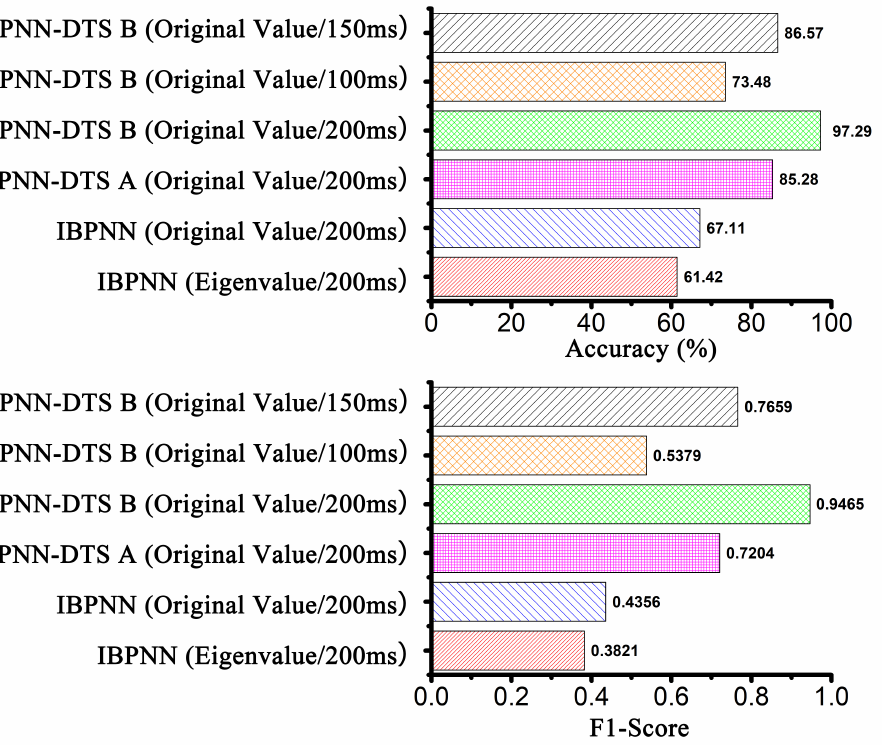
Figure 6. The evaluation index of different models with different